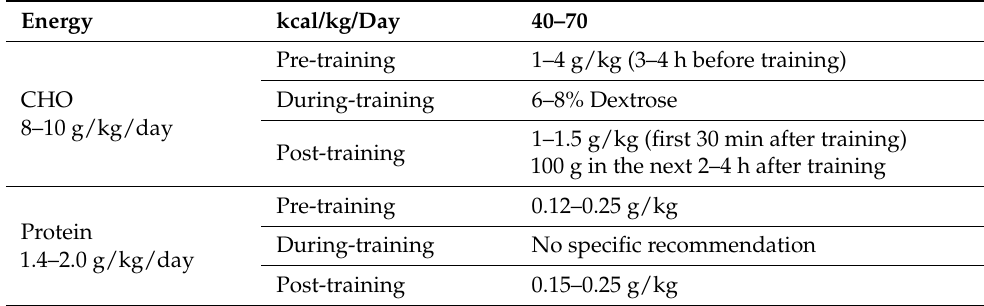
Table 1. Energy and macronutrient recommendations